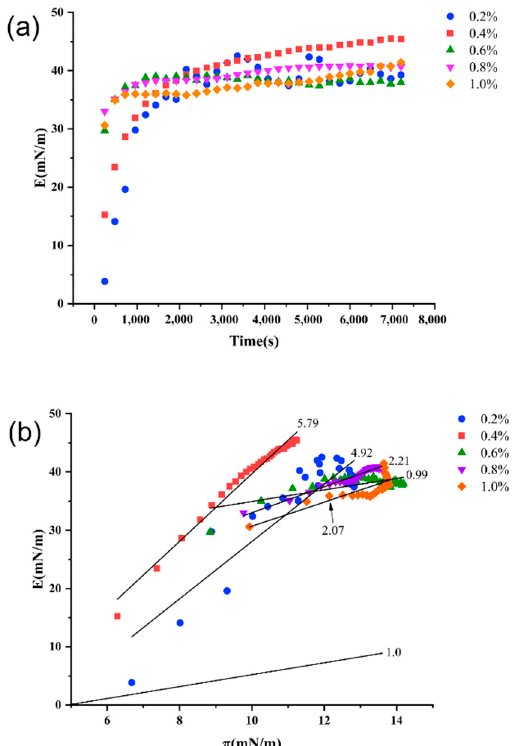
Figure 6. Time-dependent dilatational viscoelasticity modulus (E) ( a ) and the dilatational viscoelas- ticity modulus (E) as a function of surface pressure ( π ) ( b )for LSEP adsorbed layers at the MCT-water interface.